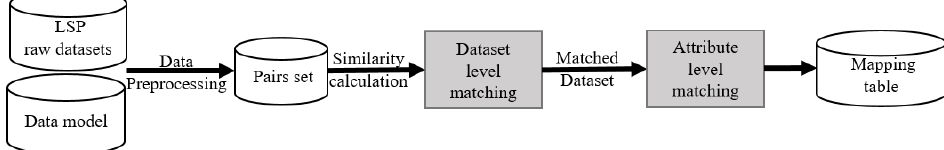
Figure 2. Schema mapping process